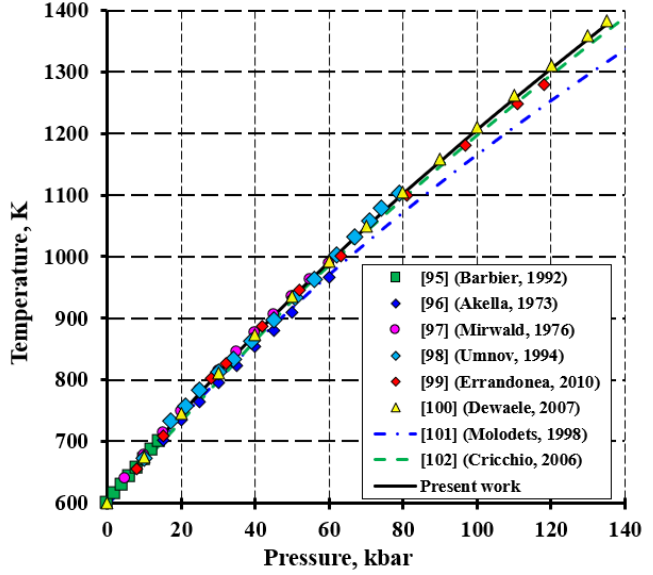
Figure 10. Melting curve of lead.